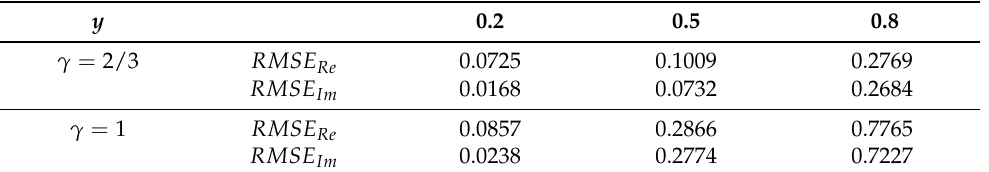
Table 1. Numerical results of Example 1 for different y and γ .